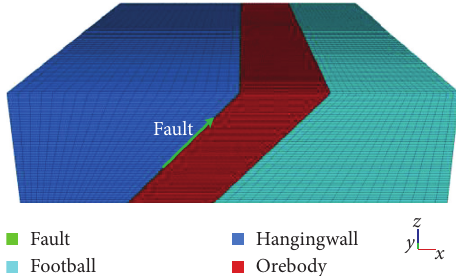
Figure 7: A 3D numerical model for mining-induced stress